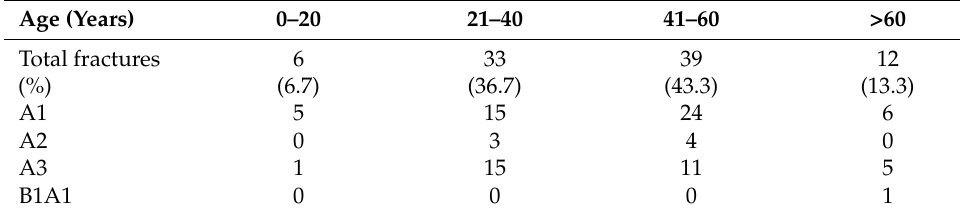
Table 3. Fracture distribution in relation to age.